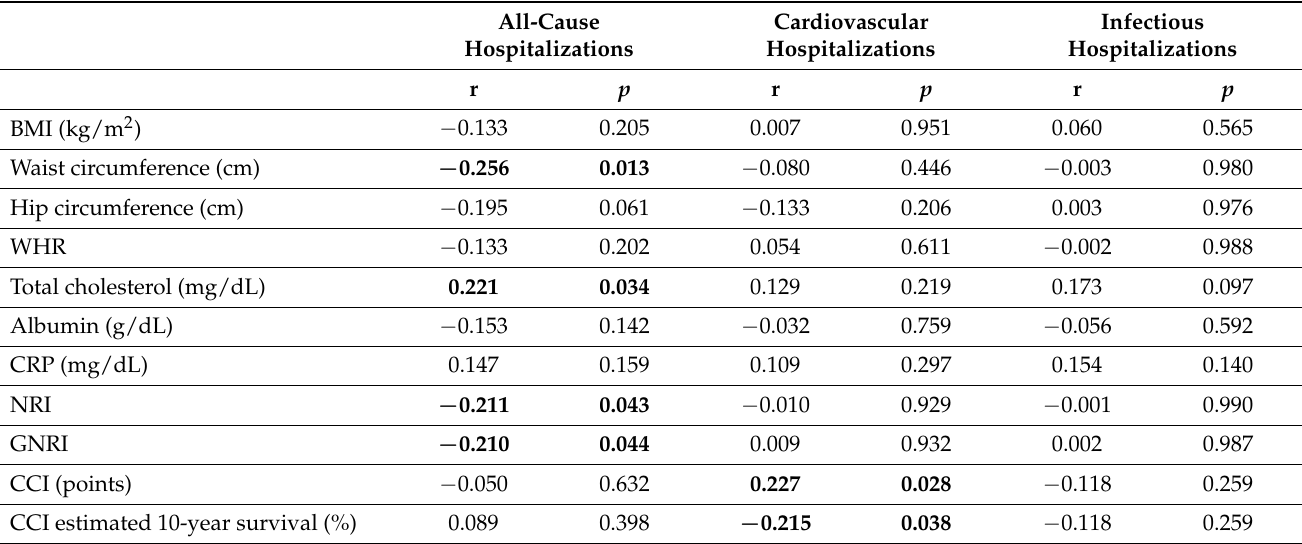
Table 7. Quantity correlation analysis of all-cause, cardiovascular, and infectious hospitalization